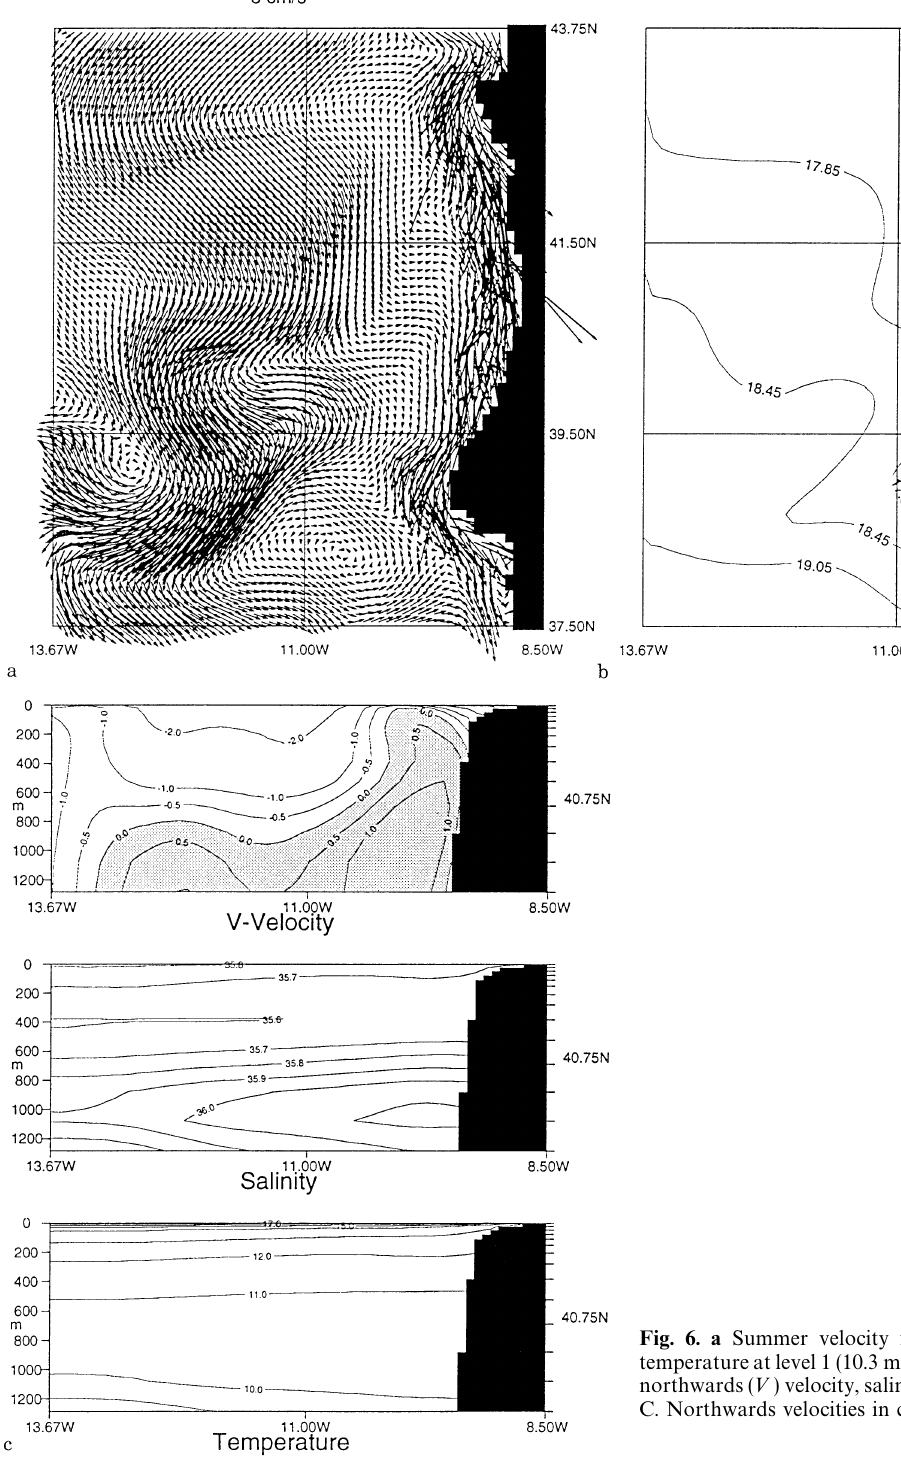
imposed boundary stream function. The flow in Fig. 8 generally provides a good comparison with observations although the magnitude of the poleward current is not as strong in the north as the observations of Frouin et al .